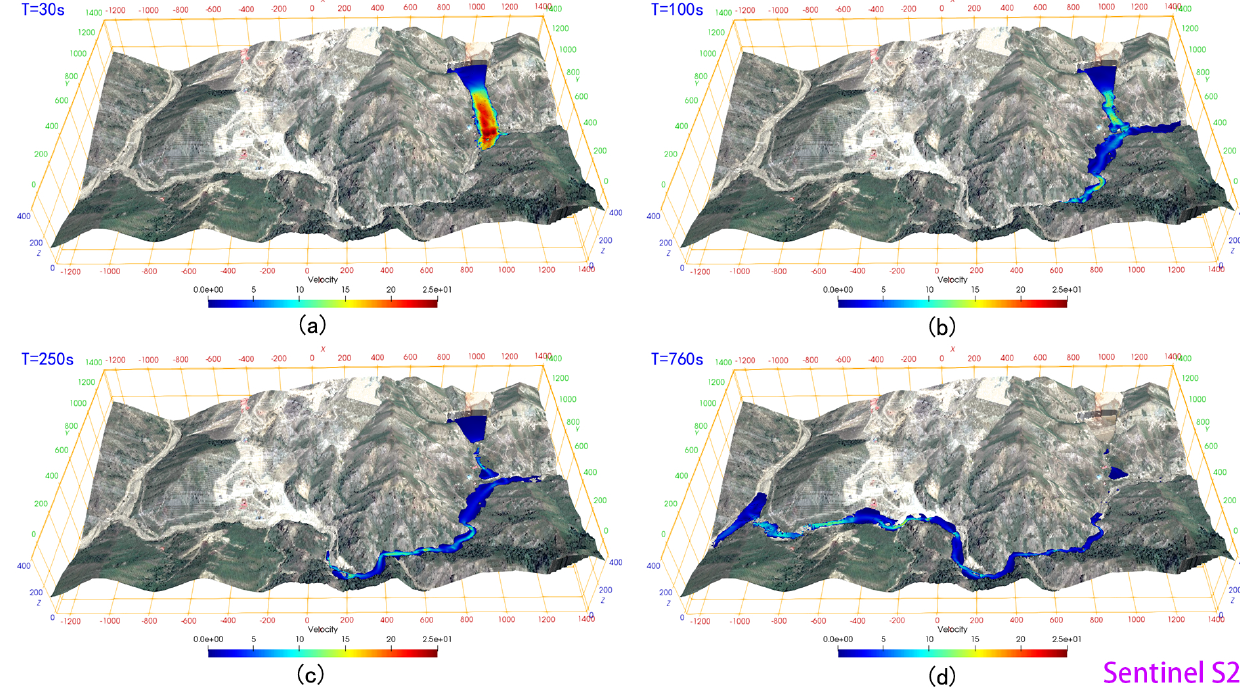
Figure 13. The time sequence of the numerically computed event up to the tailings reaching the left boundary of the computational domain. The base map is the satellite image (Sentinel S2). The color map of the simulation results is mapped by velocity characteristics.